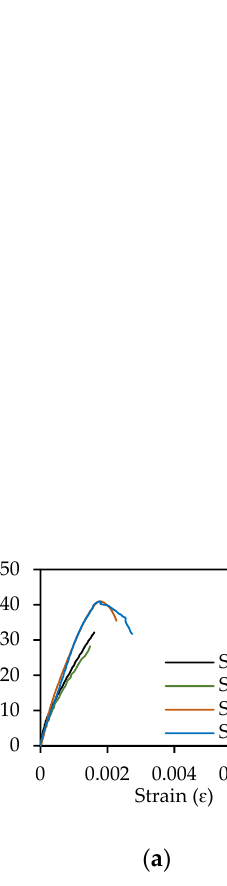
Figure 9. Predicted versus experimental cylinder compressive strength for mixtures with slag:fly ash of: ( a ) 3:1; ( b ) 1:1.